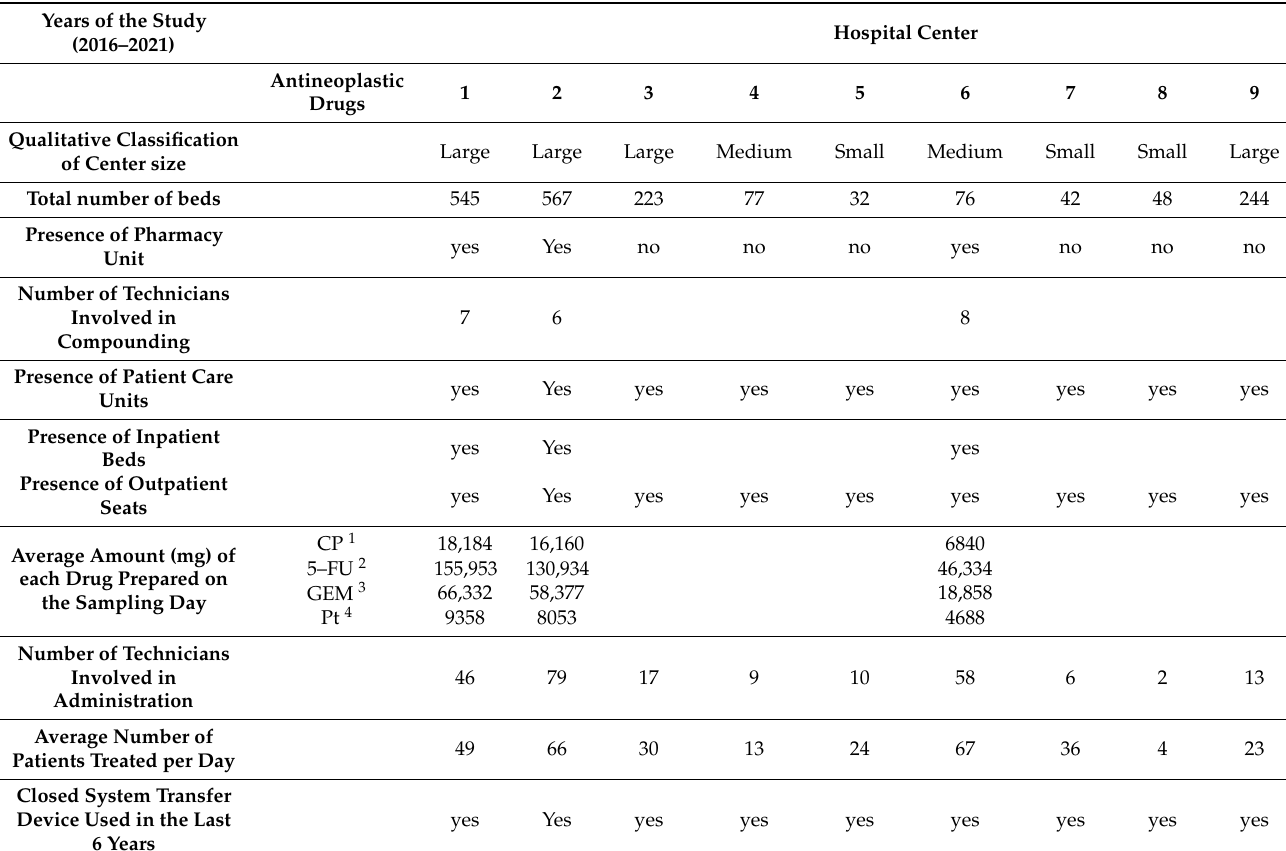
Table 1. Description of participating centers: pharmacy and patient care